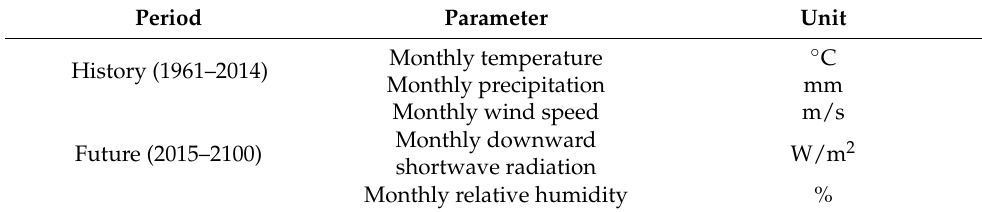
Table 1. Detailed information of parameters in climatic datasets.